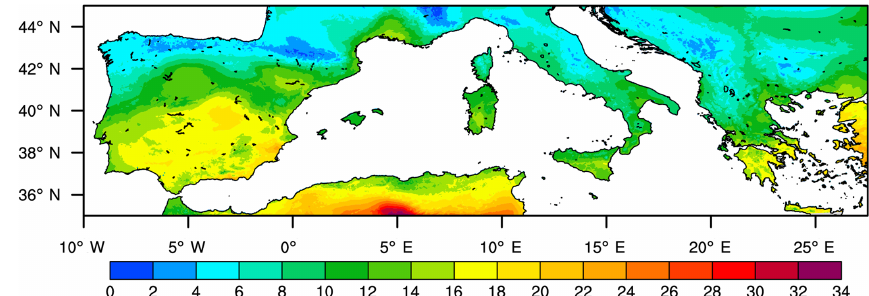
Figure 2. Spatial distribution of the FWI average over the 1979–2016